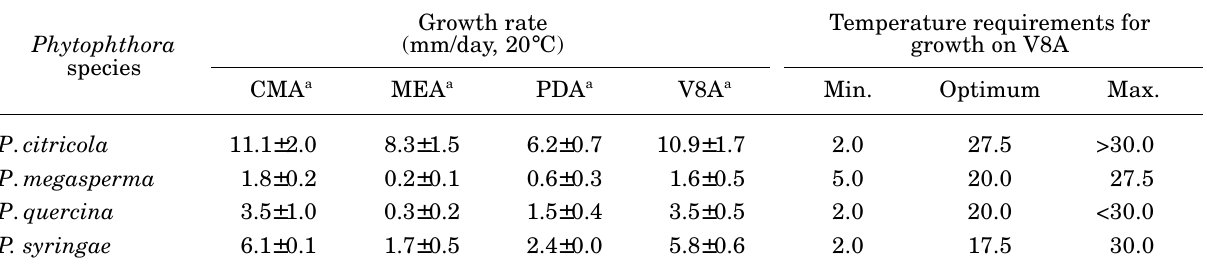
Table 4. Growth rate of four Phytophthora species on different media at 20 (cid:176) C and temperature requirements for growth on V8A (in